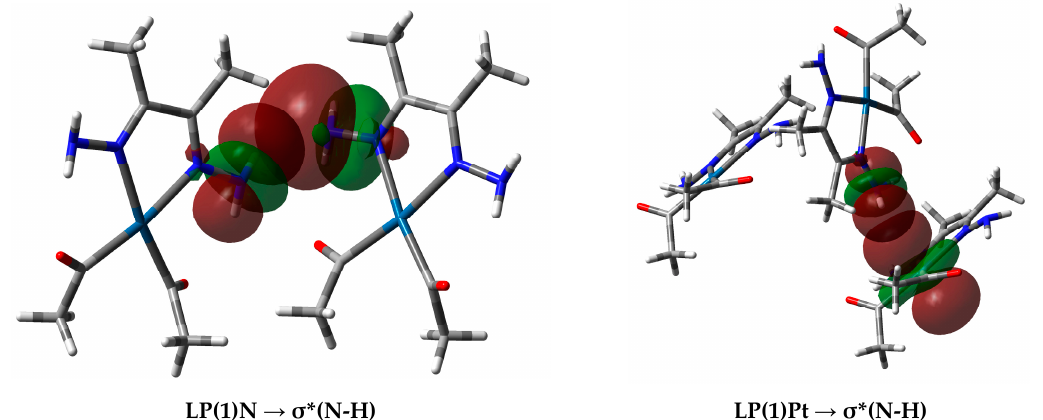
Figure 11. (Left) Interactions between the donor natural bond orbital (NBO) (LP(1)N) of the N-atom and the acceptor NBO ( σ *N-H) of the N-H ⋅⋅⋅ N (2.273 Å) interaction, and (right) donor NBO (LP(1)Pt) to the acceptor NBO ( σ *N-H) for the N-H ⋅⋅⋅ Pt (2.650 Å) interaction in complex 3 .